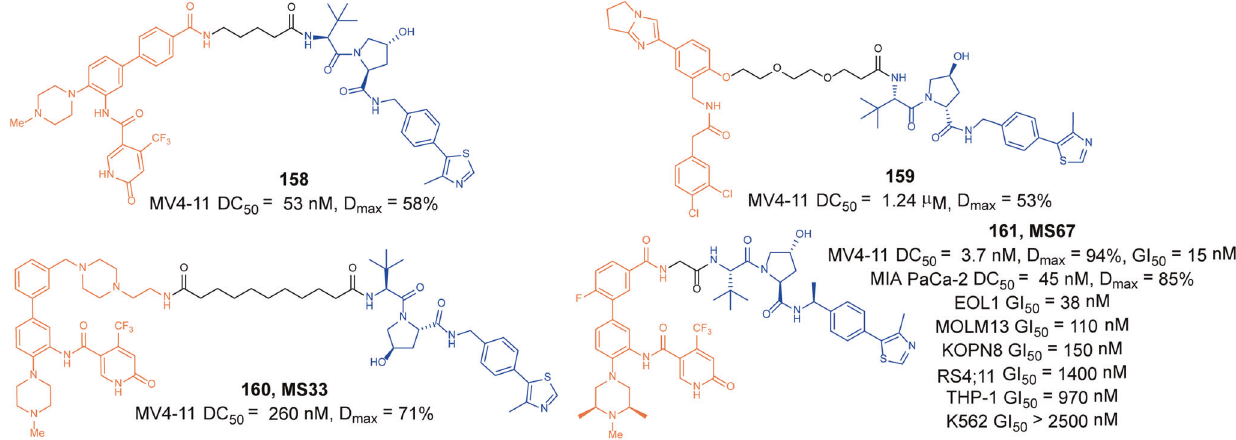
Fig. 40 The representative PROTACs targeting WDR5 Signal Transduction and Targeted Therapy (2022)